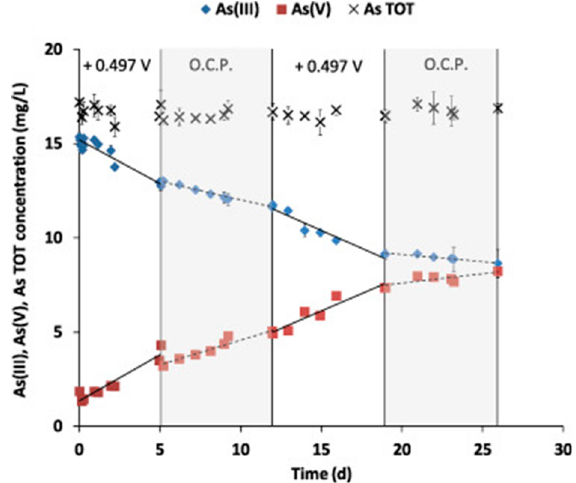
Figure 2. Evolution of As(III), As(V) and As TOT concentration during batch tests with the polarized electrode described in Pous et al. [49]. Black lines represent the As(III) removal rate, and the As(V) formation rate. Error bars represent the standard deviation of replicated analytical measurements. Reprinted from Pous et al. [49] with permission from Elsevier.